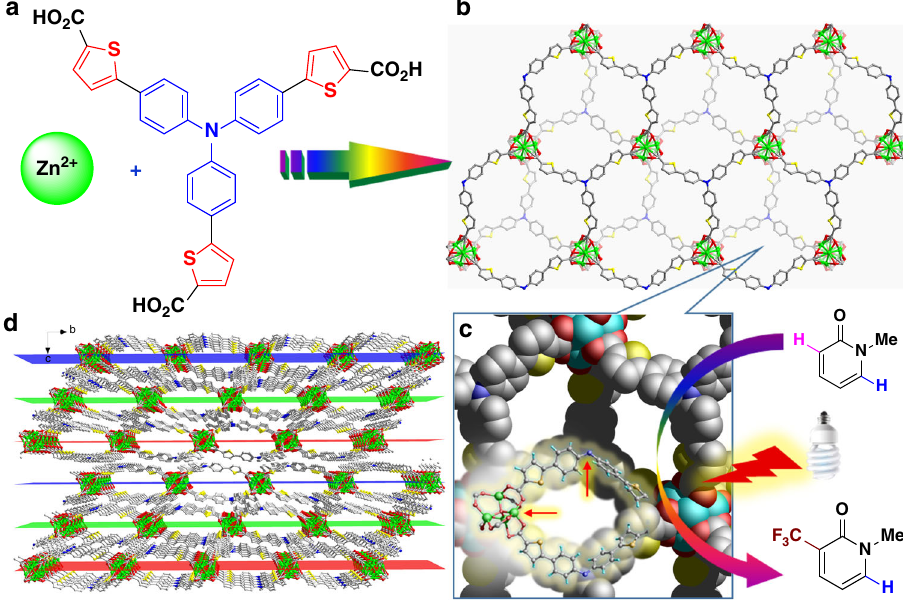
Fig. 1 Schematic illustration of the composition and structure of Zn – TCTA . a The components. b The top view of the undulating monolayer with a virtual plane. c The intralayer cage showing the potential substrate binding site. d The packing pattern and open channels along the a - or b -axis. Green, Zn; yellow, S; red, O; blue, N; gray, C. Hydrogen atoms and solvent molecules are omitted for clarity